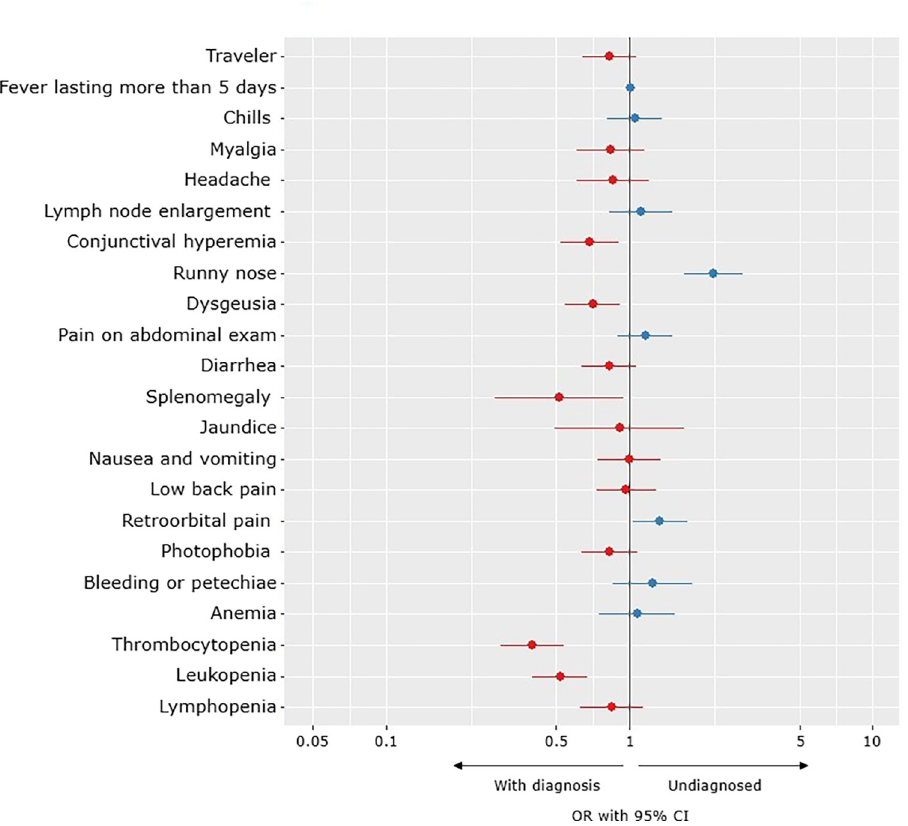
Fig 4. Clinical Features associated with the absence of a definitive diagnosis for the Acute Febrile Illness (AFI).